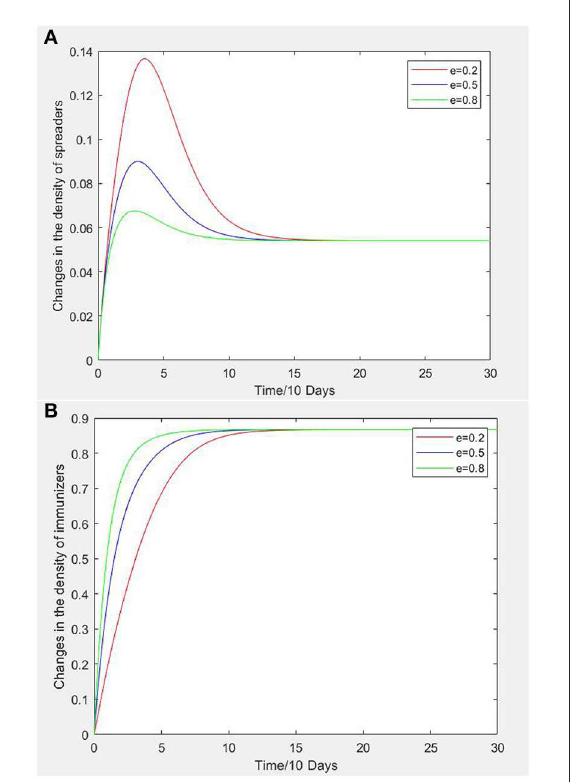
FIGURE3 (A) Variation curves of infectors density under different safety climate intensity. (B) Variation curves of recovered persons density under different safety climate